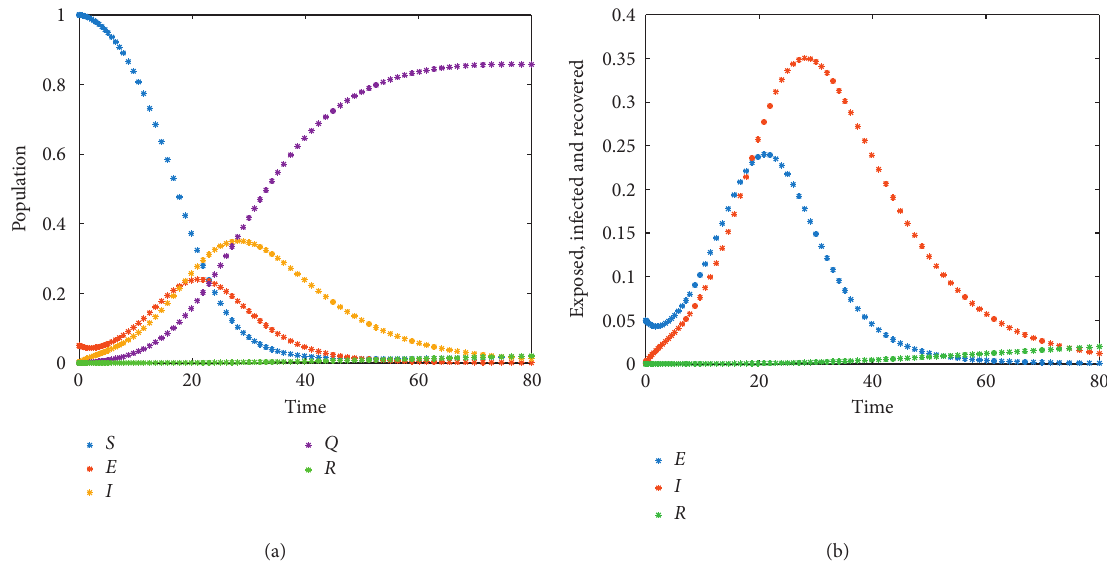
Figure 1: Dynamics of (a) all population over time and (b) exposed, infected, and recovered classes over time, when the system has no fear effect.